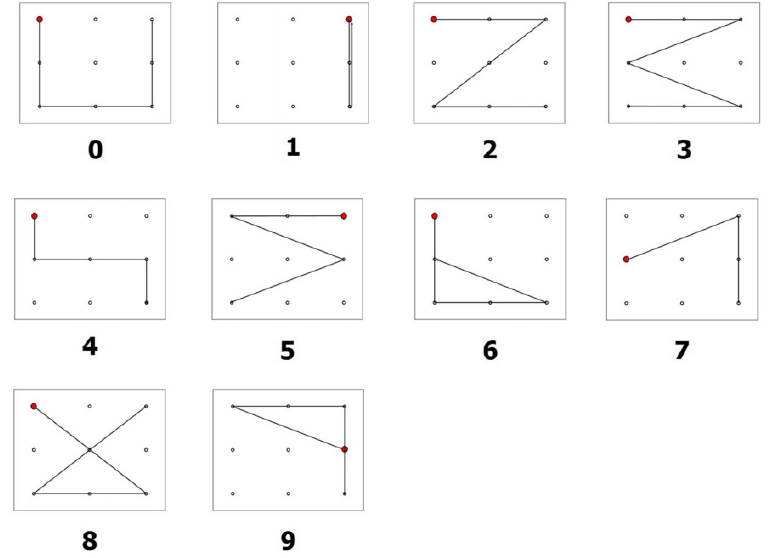
Figure 1. Pattern designs of Arabic numbers [23]. The red dots denote the starting points. Reprinted with permission.